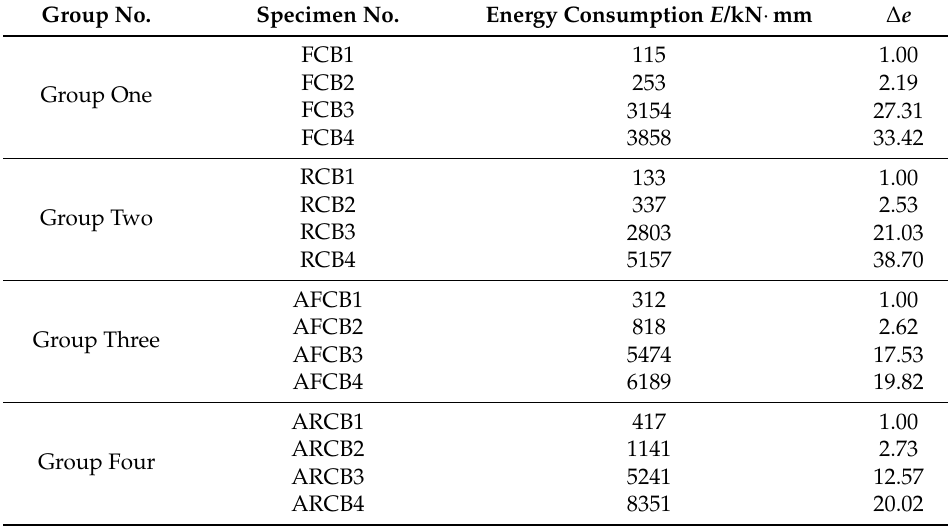
Table 4. Relative energy consumption